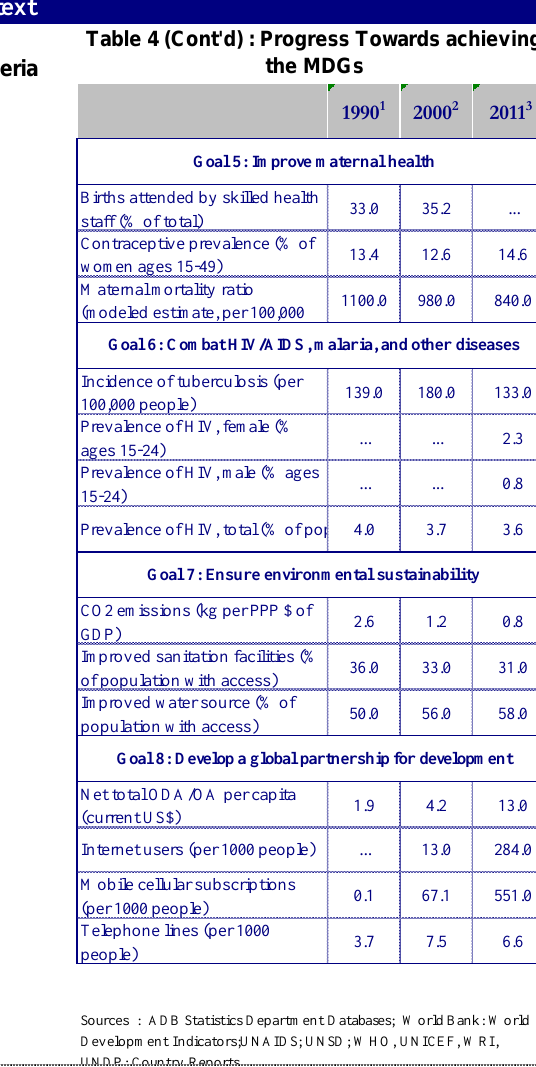
Telephone lines (per 1000 people)